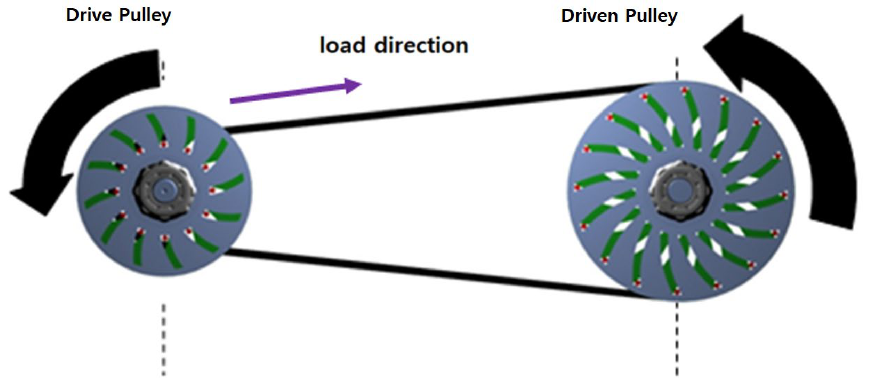
Figure 2. Principle of centrifugal belt CVT acceleration. When there is a “load” on the wheel, the “load” generates a pulling force on the belt in a direction opposite to the direction of rotation of the drive pulley. The pressing piece was contracted (moved downward) in the direction of the slide plate’s